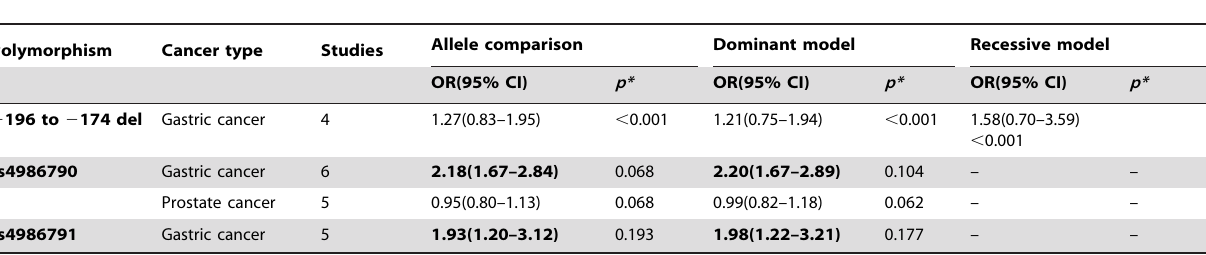
Table 4. Main result of pooled odds ratios (ORs) in gastric and prostate